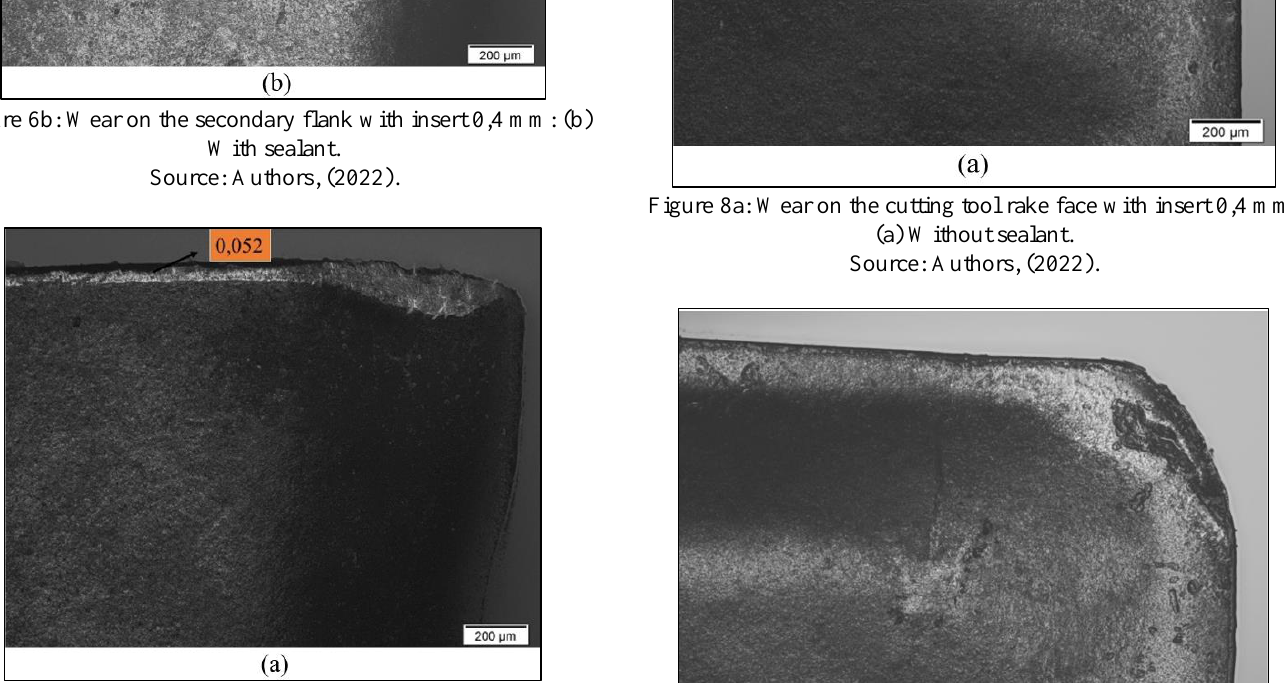
Figure 7a: Wear on the secondary flank with insert 0,8 mm: (a) Without sealant. Source: Authors, (2022).